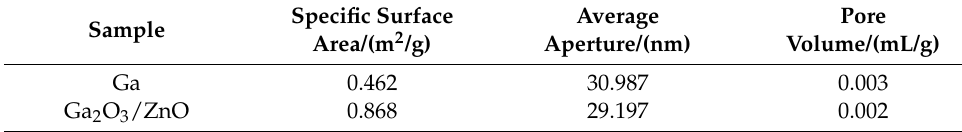
Table 1. The sample–specific surface area, pore diameter, and pore